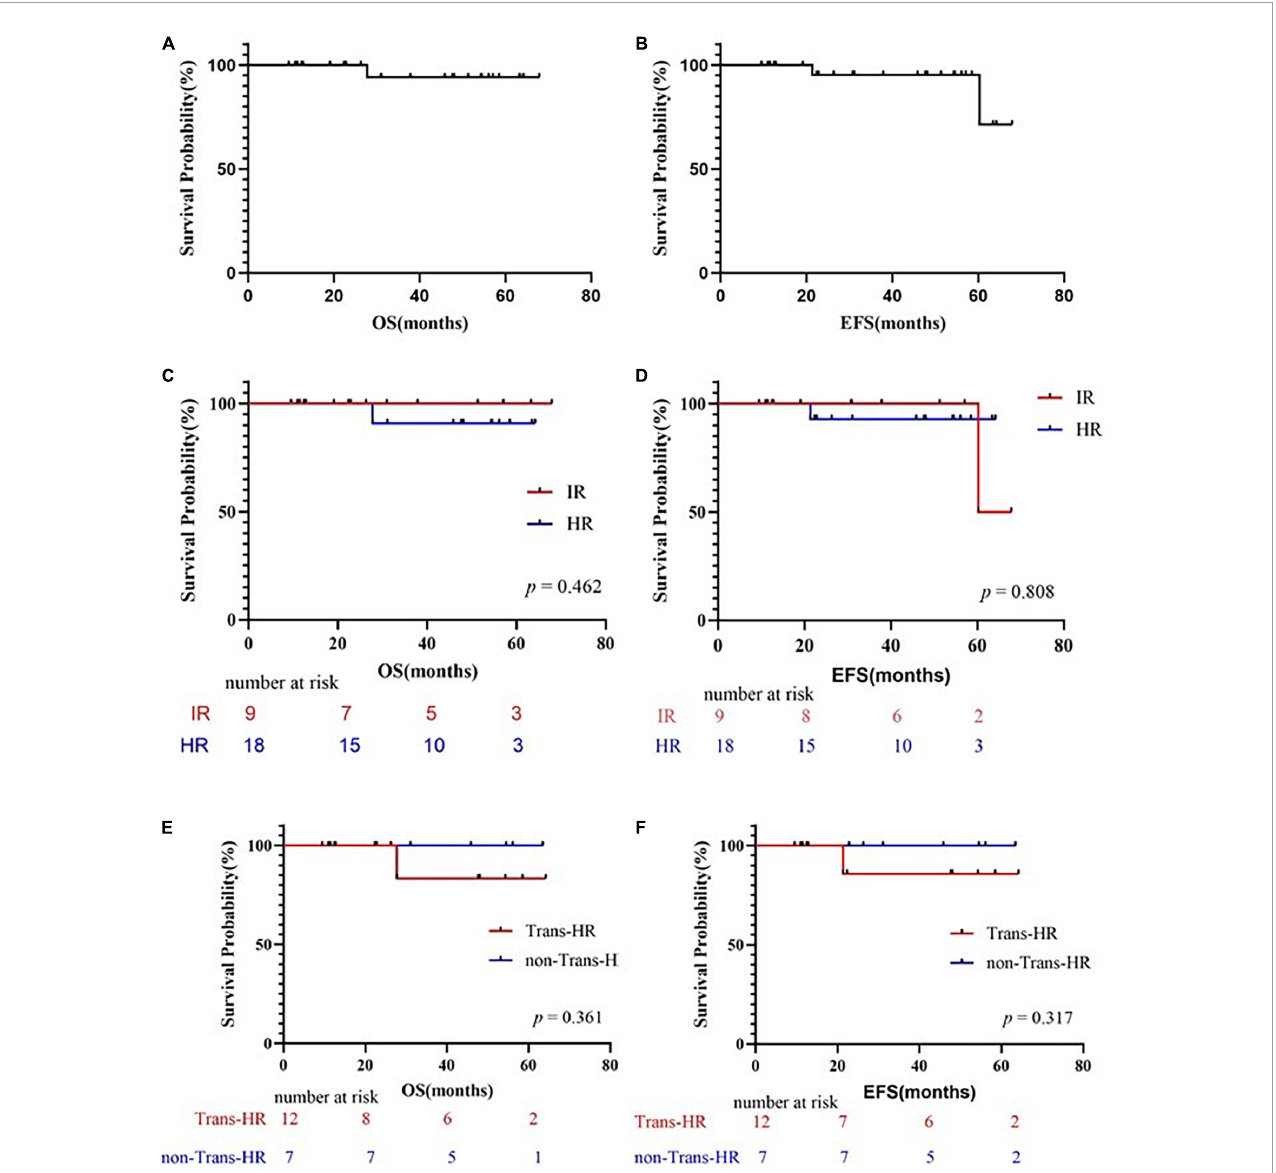
FIGURE1 Survival curves. (A) Probability of overall survival (OS) for patients treated with Chidamide. (B) Probability of EFS for patients treated with Chidamide. (C) Comparing the probability of OS for patients treated with Chidamide in IR group and HR group. (D) Comparing the probability of EFS for patients treated with Chidamide in IR group and HR group. (E) Comparing the probability of OS for patients treated with or without HSCT. (F) Comparing the probability of EFS for patients treated with or without HSCT. OS, overall survival; EFS, event-free survival; IR, intermediate-risk; HR, high-risk;